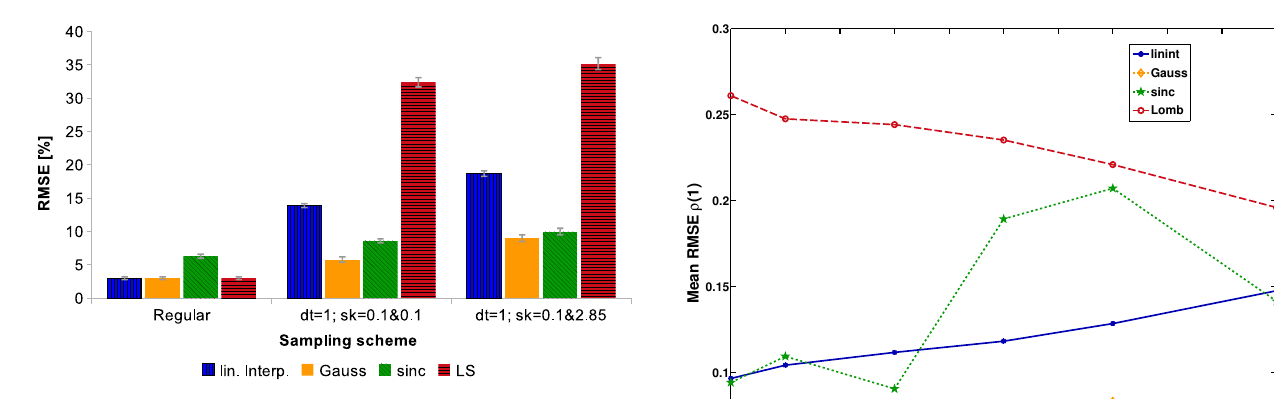
Fig. 9. RMSE for the CCF estimation (at the lag of coupling) us- ing linear interpolation, Gaussian or sinc kernel or the inversion of the LS Periodogram of time series from coupled AR(1) processes (cf. Eqs. 15, 16) – given for regular and two gamma-distributed sam- plings with mildly irregular (skewness sk x and sk y = 0 . 1) and very irregular (skewness sk x = 0 . 1, sk y = 2 . 85) inter-observation-times. Errorbars give the standard deviation of the estimate, calculated us- ing 1000 bootstrap iterations.